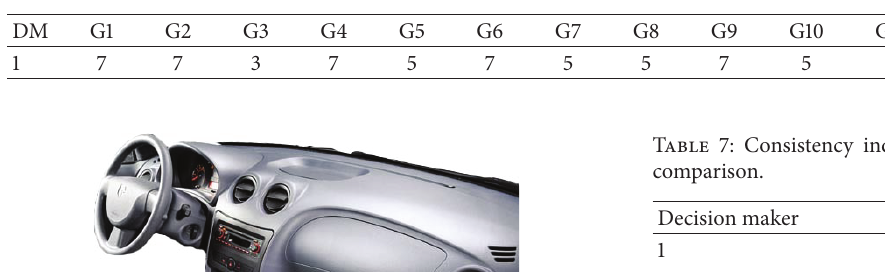
Table 4: Score parameters influencing decision in subcriteria level for the general group.